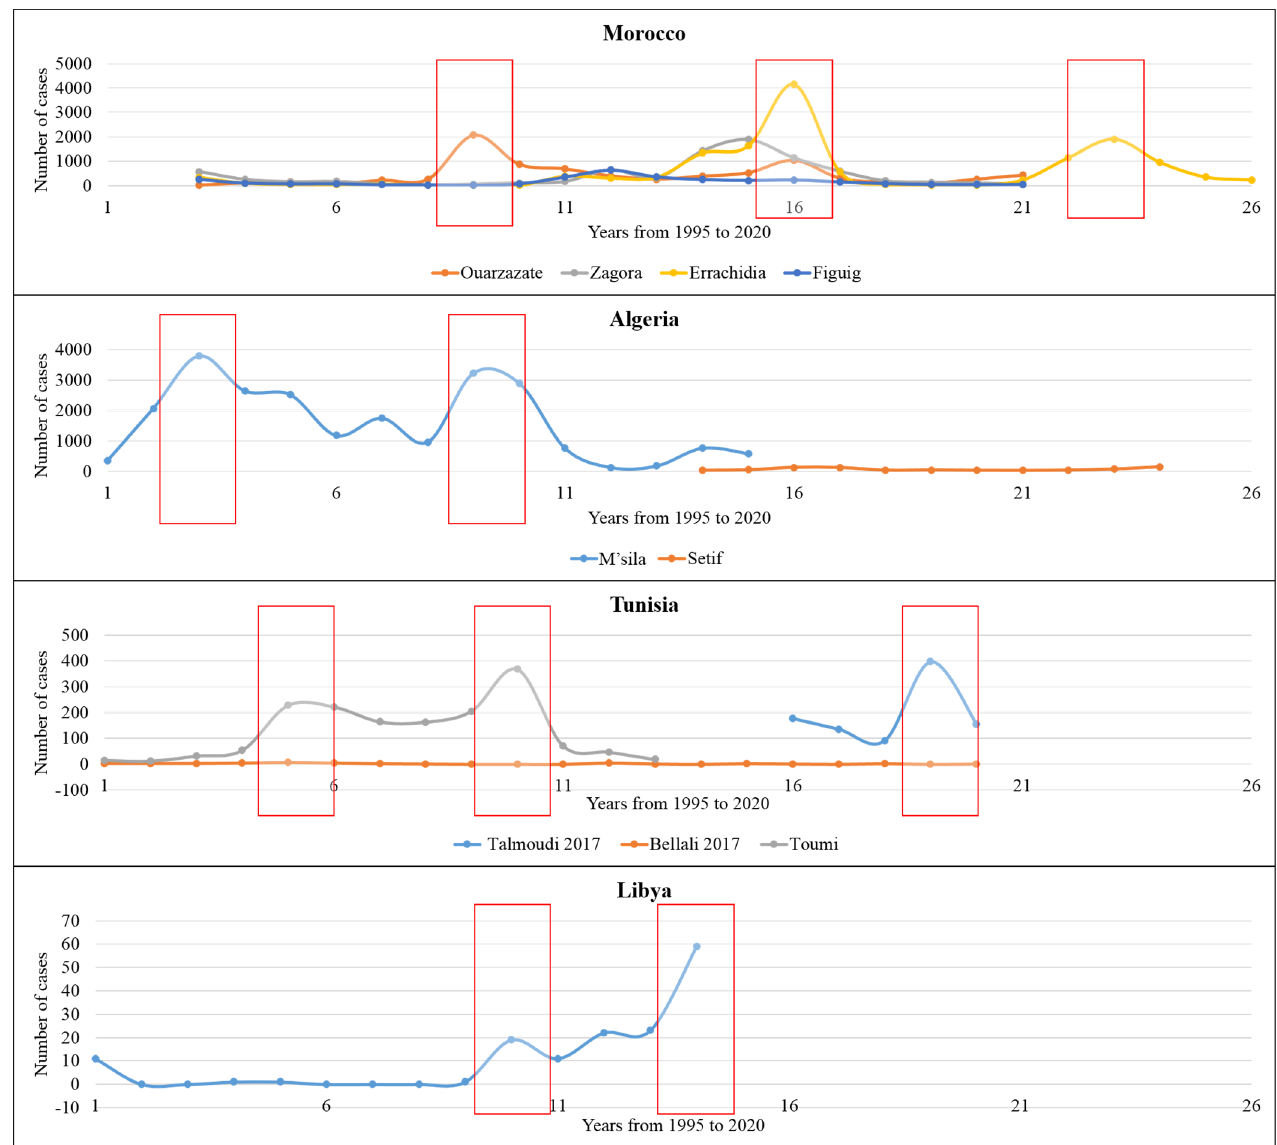
Figure 3. The evolution of ZCL cases in North African countries from 1995 to 2020 (26 years) as revealed by the systematic review and meta-analysis. The red box refers to the year with the peak of incidence.